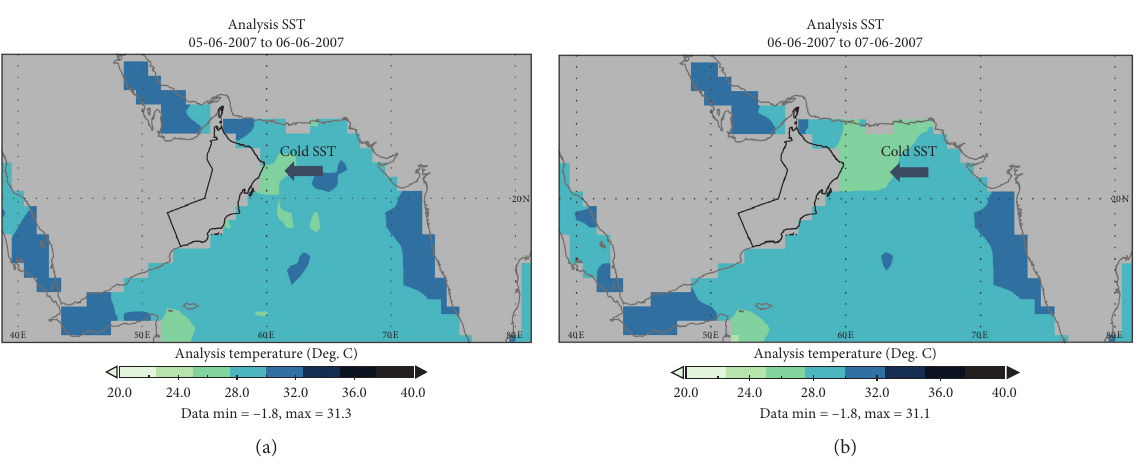
Figure 6: The Sea Surface Temperatures in ° C on (a) 5th of June 2007 (b) 6th of June 2007 at 04 LTwith spatial resolution (100 KM) (Source: NOAA,